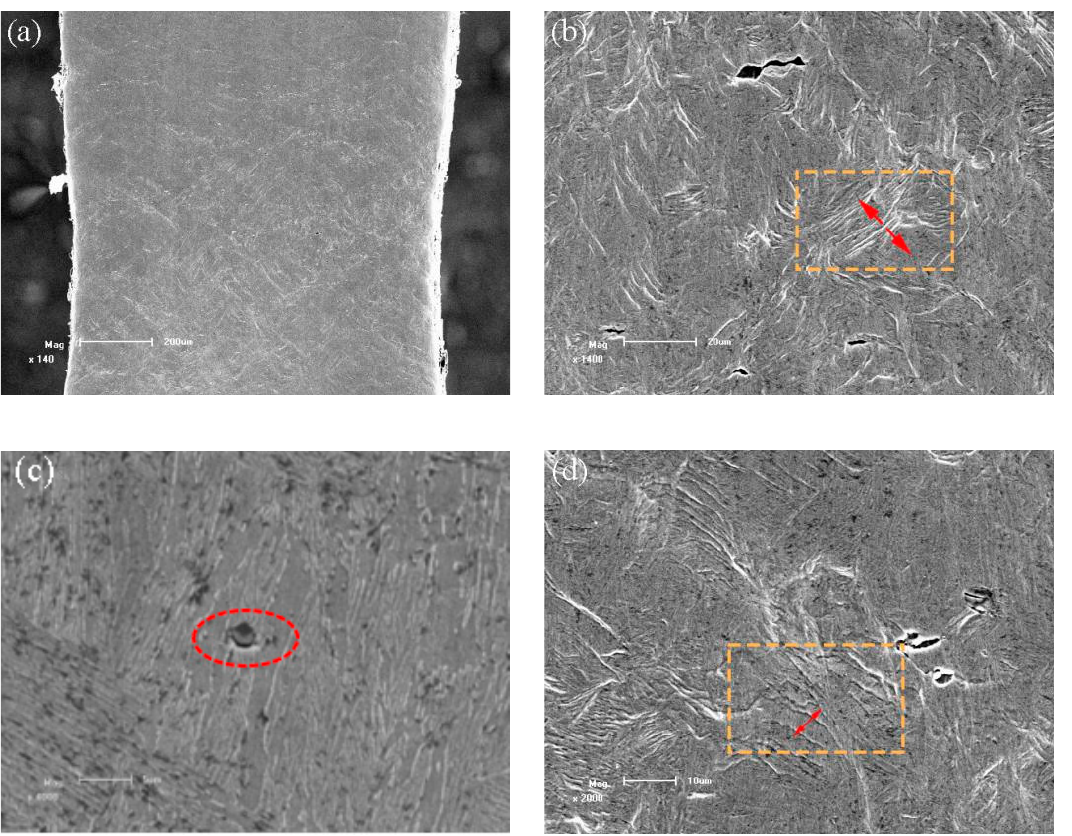
Figure 5. Microstructure characteristics of N1 steel under uniaxial tensile stress (Under 879 N): ( a ) necking has occurred prior to fracture; ( b ) micro-cracks in the substrate; ( c ) the voids initiated at inclusions; ( d ) micro-cracks near the inclusion.